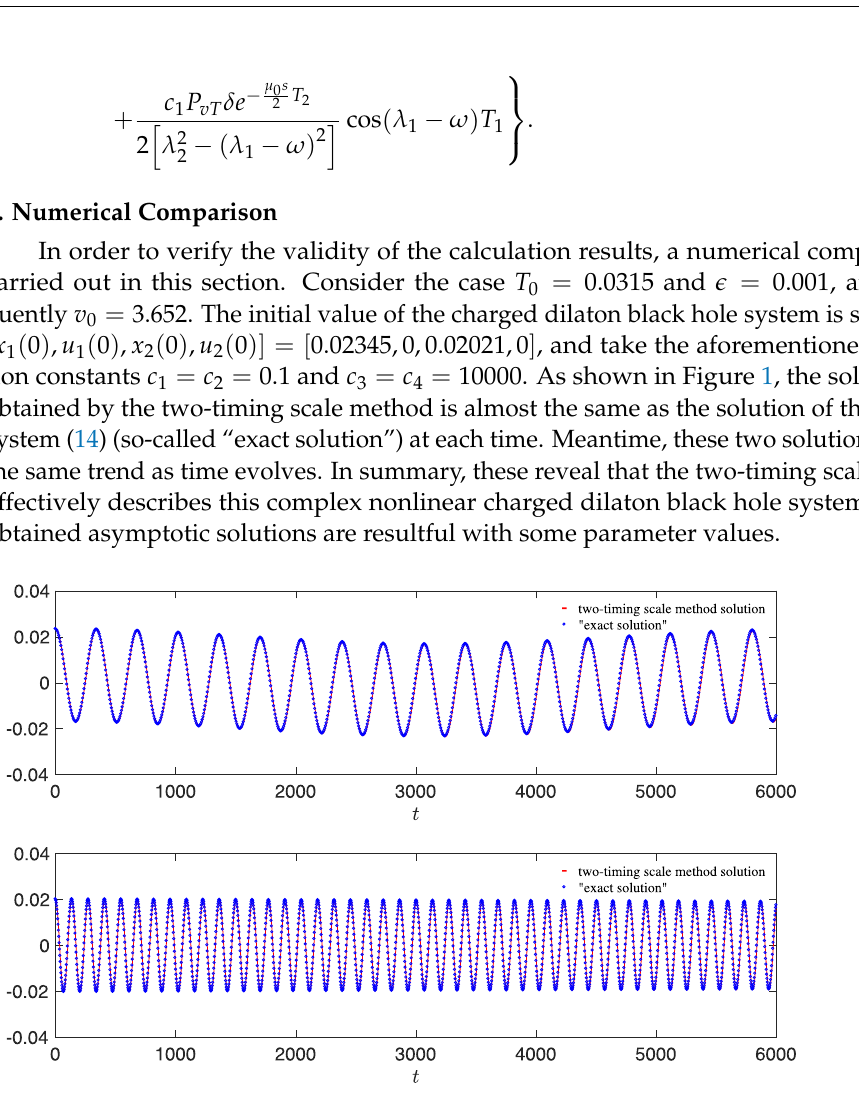
Figure 1. A comparison between the two-timing scale method solution and the “exact solution” for q = 1, α = 0.01, b = 1, A = 0.3703, s = 0.04, µ 0 = 0.1, ω = 0.01, δ = 0.004 and (cid:101) = 0.001.